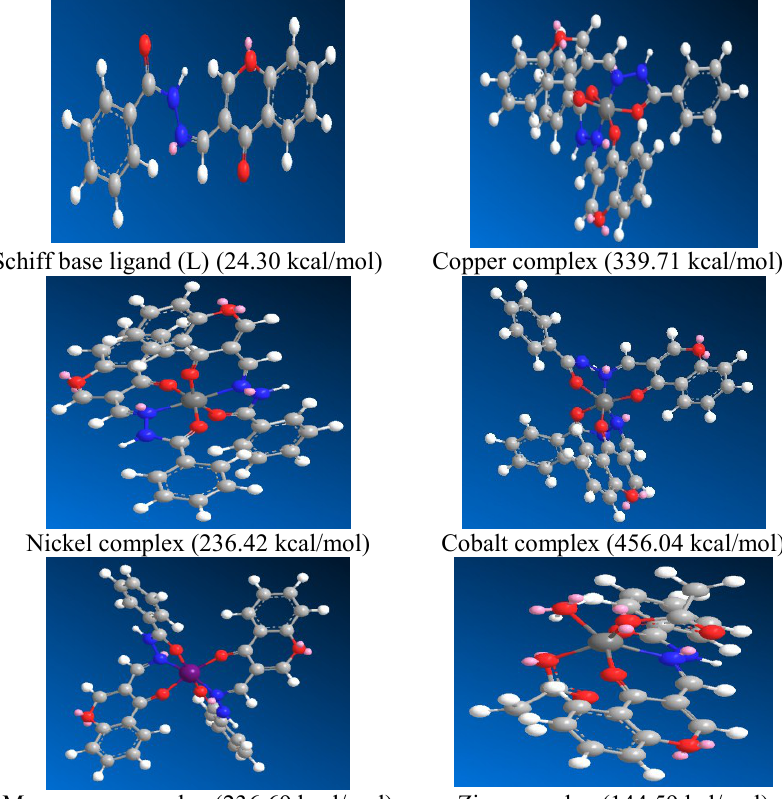
Figure 3. Molecular modelings of the proposed structures.